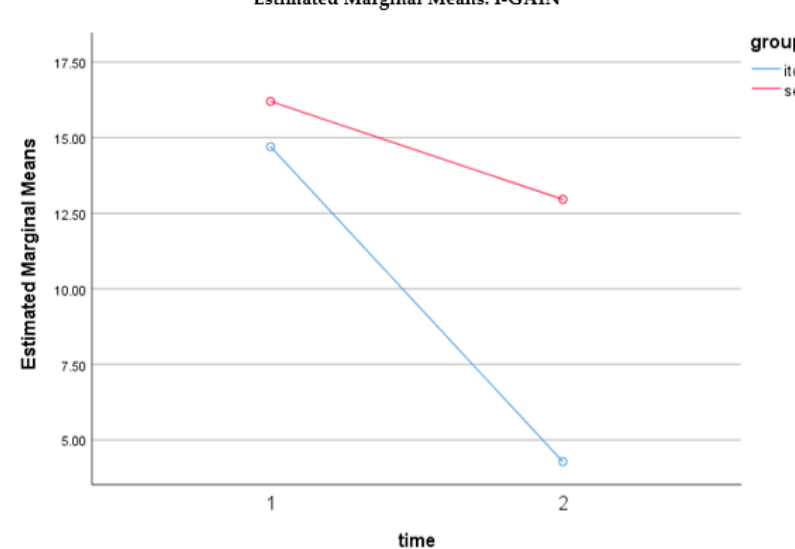
Figure 3. Estimated marginal means of I-GAIN